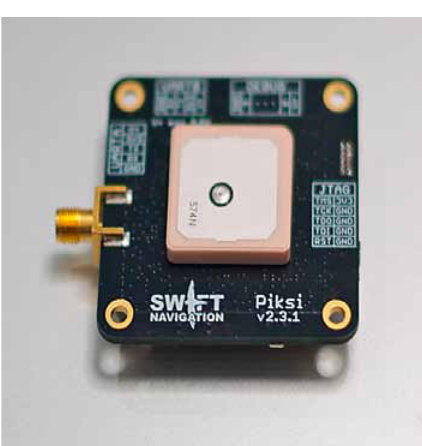
Fig. 4. Distribution of LitPos stations (source: